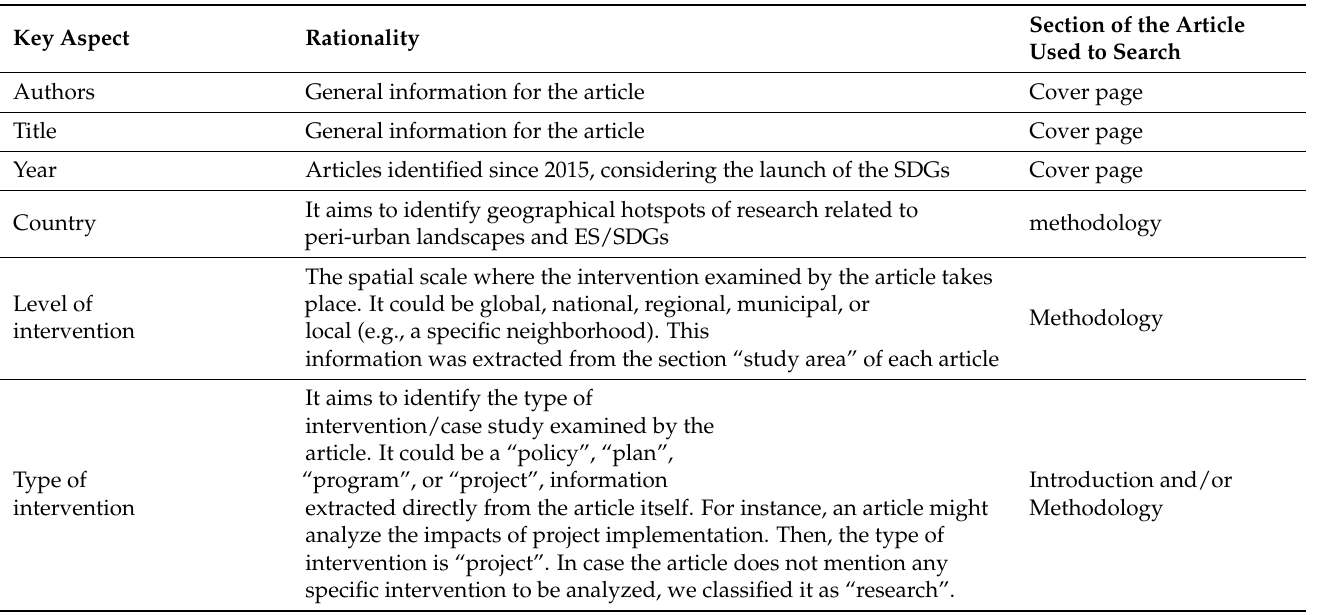
Table 1. Review framework and key aspects for